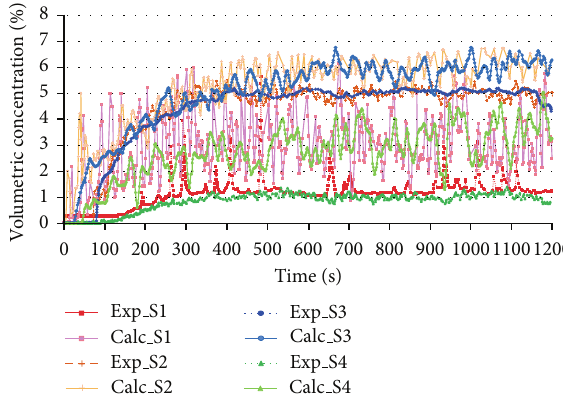
Figure 5: Comparison of numerical and experimental results.